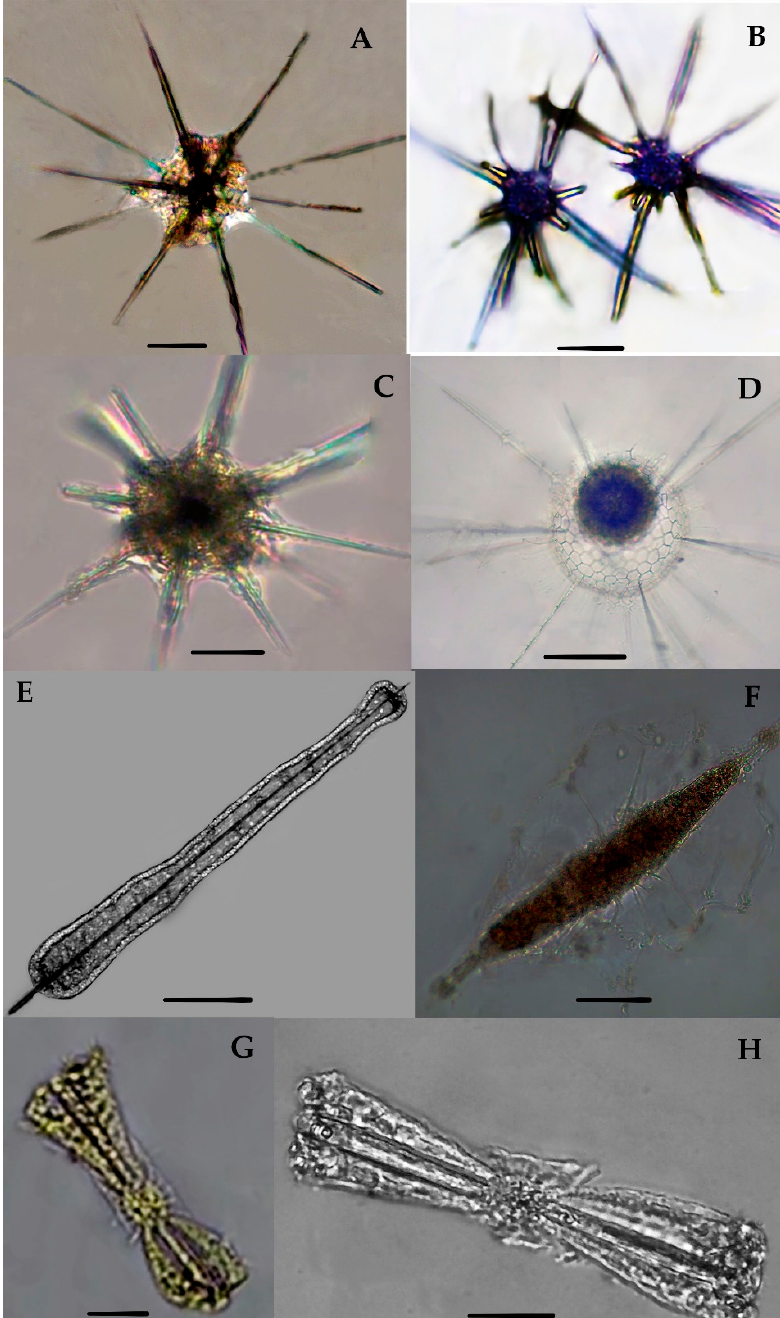
Figure 2. Photomicrographs of Acantharian species ( A – G ). The images have been modified from Munir et al. [27]. ( A ) Acanthochiasma fusiforme , ( B ) Trizona brandti and ( C ) Acanthostaurus conacanthus have asteroid-shaped shells with a central capsule and 10–20 radical spines.( D ) Dictyacantha tabulate/Tessaropelmida has a spherical shell with mesh-type central capsules and thin spines, ( E ) Amphilonchea elongate/Amphilithium clavarium/Amphilithium concretum has an elongated shell with 2 apical spines and shorts spines in the central capsular shell,( E ) is the broken cells; contains 2 apical spines, ( F ) Amphibelone cf. Anomala, ( G ) Diploconnus faces , ( H ) Diploconnus cylindericus have a bell-shaped shell with a short capsular area containing short radical spines and prominent long cornets. Scale bars: 10–50 mm.